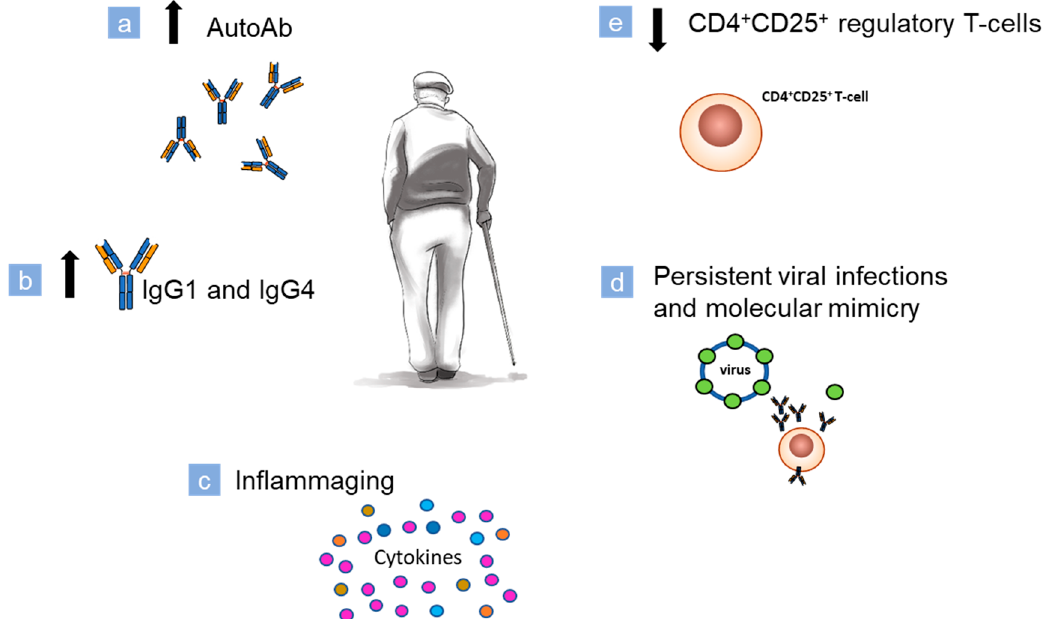
Figure 3. Aging-associated mechanisms that could contribute to the induction of BP onset. Ageing is accompanied by a process of remodeling/restructuring that involves immune system termed immunosenescence. ( a ) In the elderly, the production of low-affinity immunoglobulins increases, and ( b ) serum levels of IgG1 and IgG4 raise; ( c ) a chronic, sterile, low grade inflammation background is typical of the elderly. This condition (of basal cytokines production) could act as a stimulus for the autoimmunity onset; ( d ) in the elderly, infections are common and persistent. In a dysregulated immune system, peptides of an infective agent could lead to a cross-reaction against self-peptides with similar sequences. ( e )The compartment of regulatory CD4 + CD25 + T-cells tends to decrease. These regulatory cells are able to counteract the occurrence of autoimmune events. Thus, a decline in their number could favor the development of autoimmune